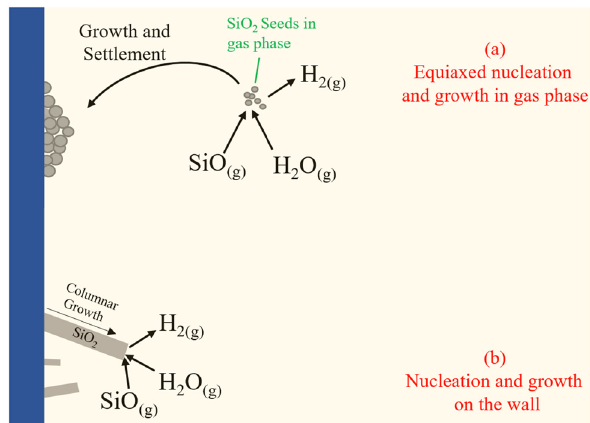
Figure 12: The schematic illustration of the silica fume formation in gas re fi ning of Si. ( a ) The equiaxed growth and ( b ) nucleation on surface.